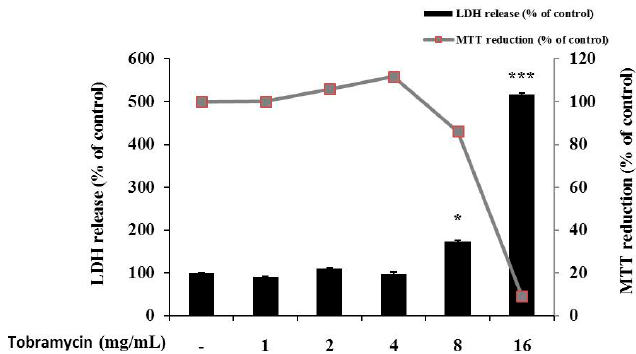
Figure 2. Cell viability of tobramycin-treated B16F10 melanoma cells. The cells were supplemented with various concentrations of tobramycin for 72 h. Data are presented as mean ± standard deviation (SD) of at least four independent experiments ( n = 4). ** indicates p < 0.01, *** p < 0.001 vs. untreated cells.